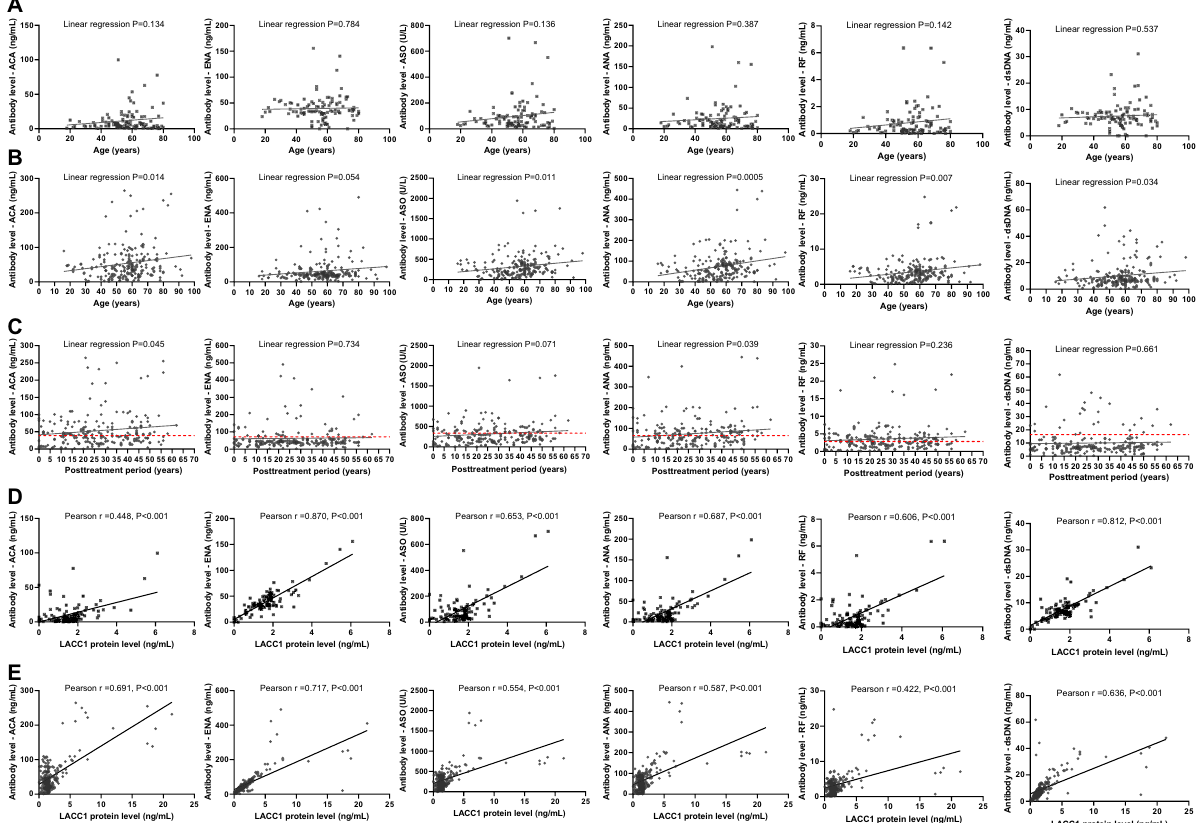
Figure 2. Correlation of the levels of autoantibodies with aging, posttreatment period, and LACC1 protein level. ( A ) Alteration of the autoantibodies in plasma of controls along age (years). ( B ) Alteration of the autoantibodies (ng/ml) in plasma of cured patients along age (years). ( C ) Lifelong presence of the autoantibodies in plasma of cured patients. whereas the alteration of the autoantibodies along time of post- treatment (years) was measured by linear regression. ( D ) Correlation of the levels of the autoantibodies with the level of LACC1 protein (ng/ml) in plasma of controls. ( E ) Correlation of the levels of the autoantibodies with the level of LACC1 protein (ng/ml) in plasma of cured patients. * In linear regression analysis, there is linear correlation when P < 0.05. In Pearson correlation analysis, there is correlation when P < 0.05, and the correlation is negative when R < 0, positive when R >